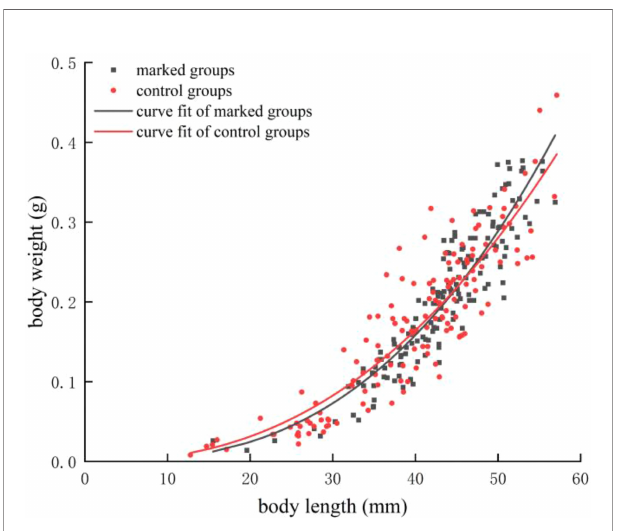
FIGURE 3 | Body length and body weight of Coilia nasus larvae in the marked and control